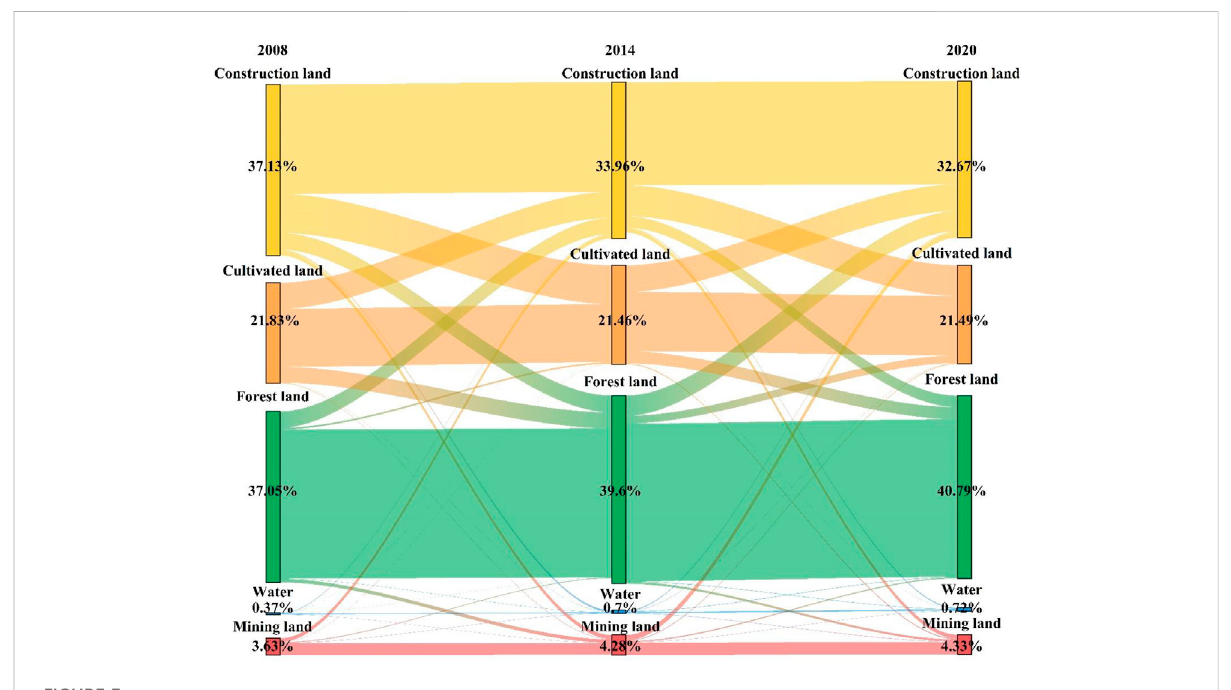
FIGURE 3 The transfer situation of various land use types in urban area of Anshan.